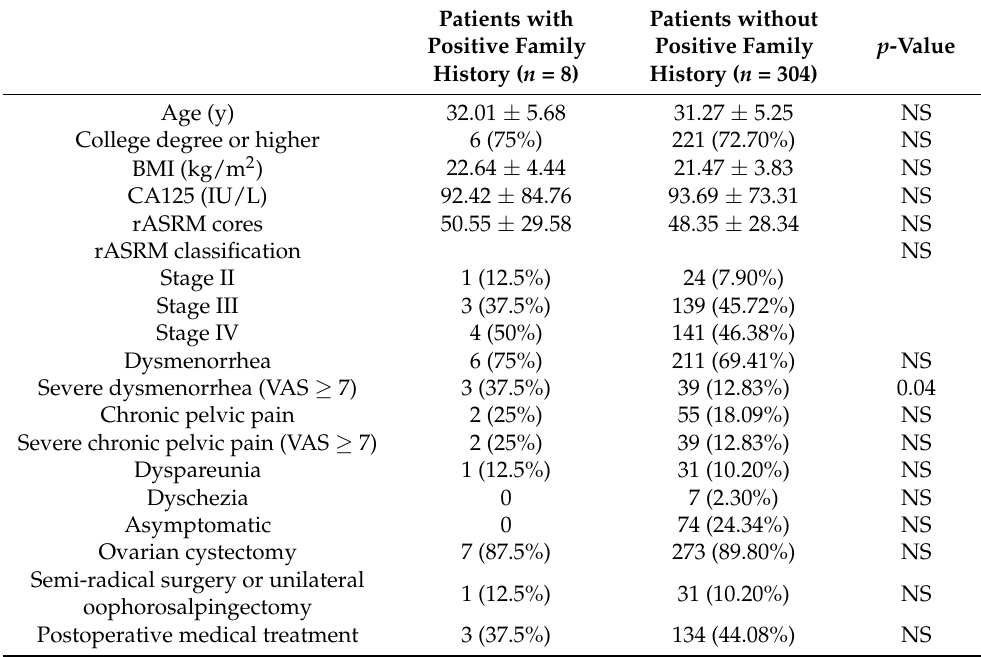
Table 4. Comparison of characteristics between primary endometriosis patients with and without family history.